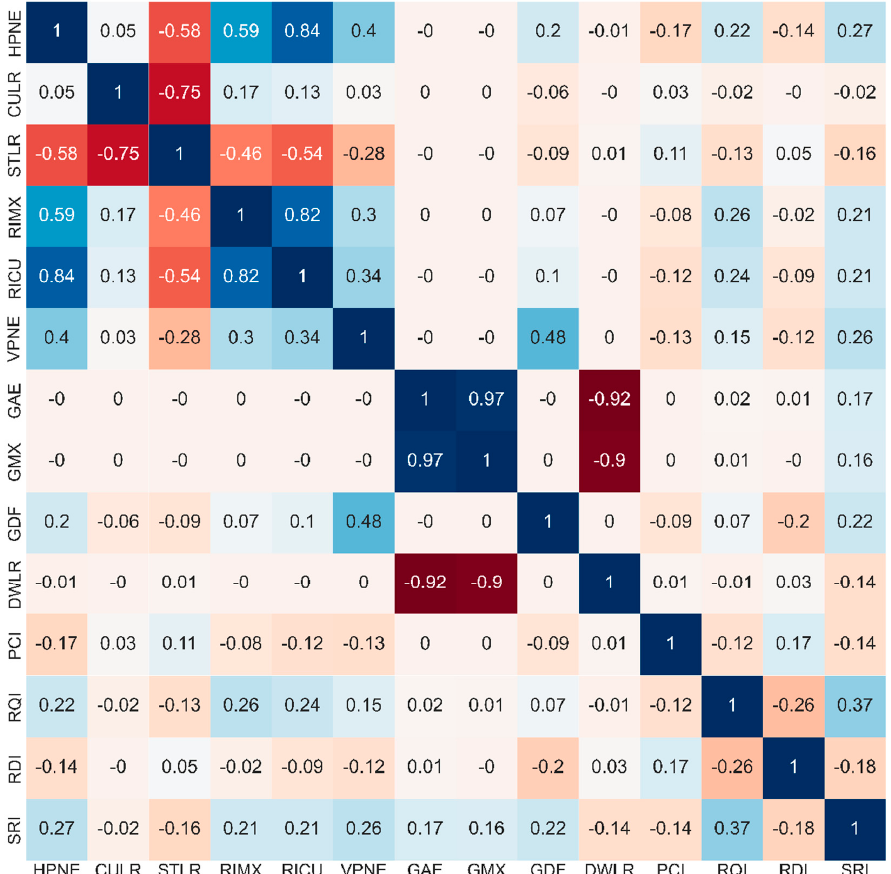
Figure 4. Pearson correlation matrix of continuous feature variables. If the correlation coefficient is greater than 0, it is a positive correlation, and if it is less than 0, it is a negative correlation. The stronger the correlation, the darker the color. The stronger the positive correlation, the closer to blue; the stronger the negative correlation, the closer to red.